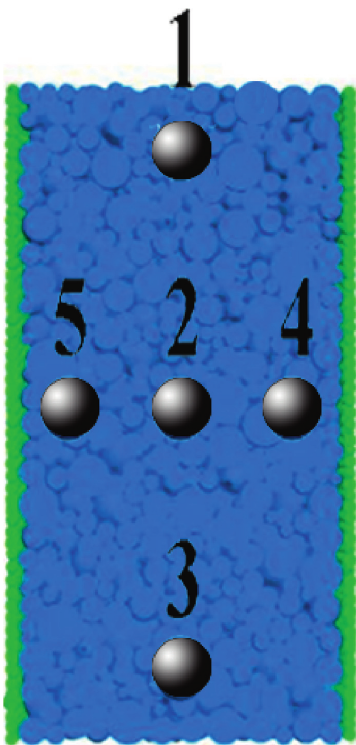
Figure 11: Schematic diagram of measurement circles.